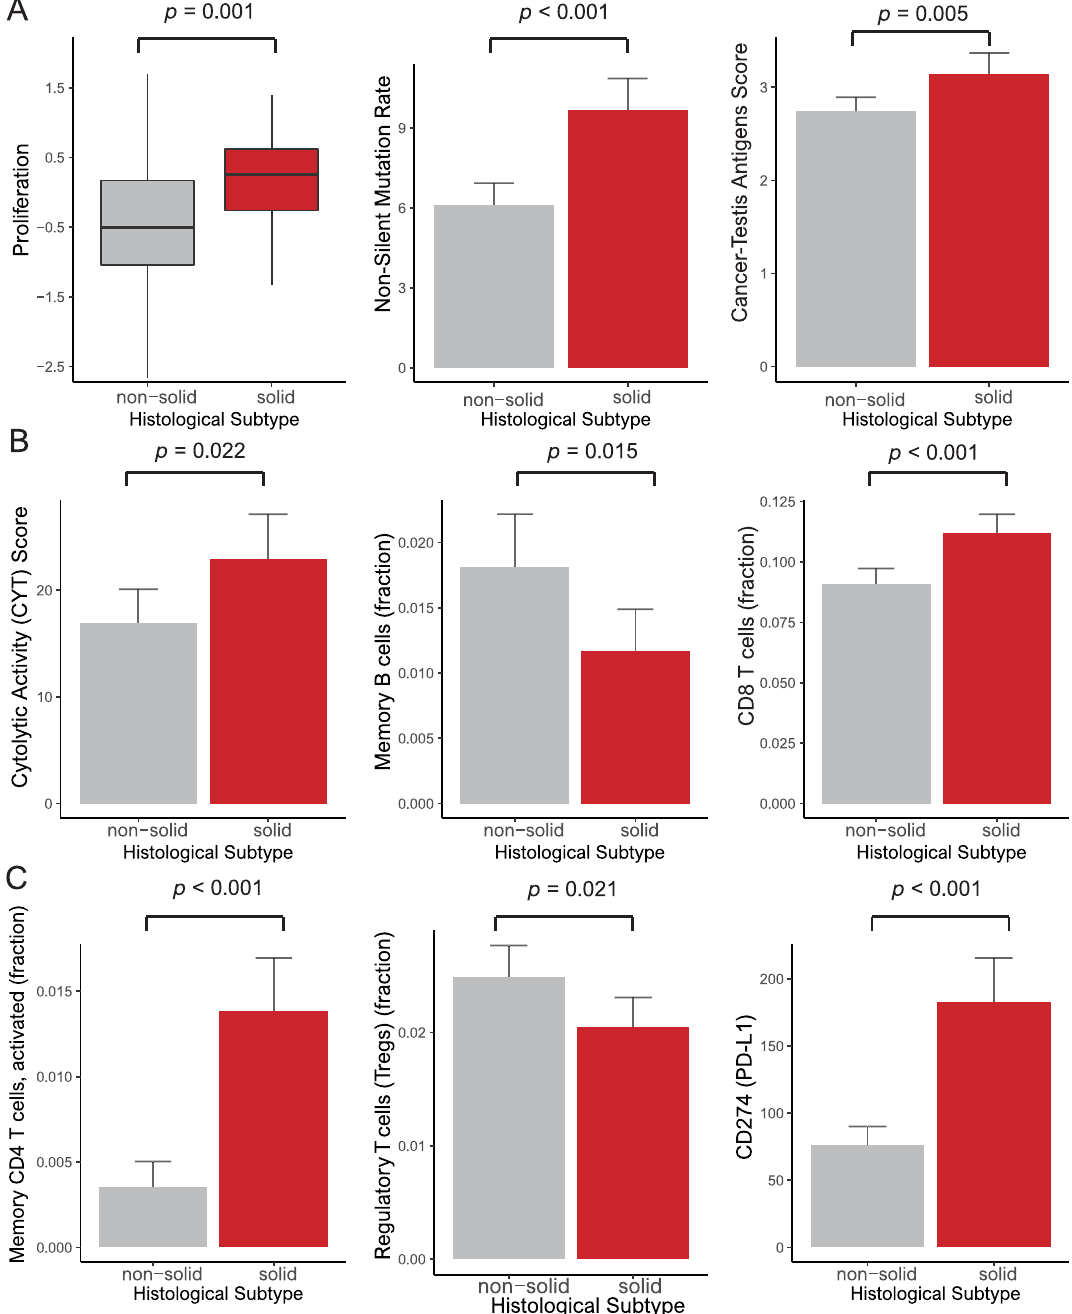
Figure 3. Bar plots of the solid type. ( A ) Proliferation, non-silent mutation rate and cancer-testis antigen score ( p = 0.001, < 0.001 and 0.005, respectively). ( B ) Cytolytic activity score, memory B cells and CD8 T cells ( p = 0.022, 0.015 and < 0.001, respectively). ( C ) Activated memory CD4 T cells, regulatory T cells and CD274 (PD-L1) ( p < 0.001, 0.021 and < 0.001,